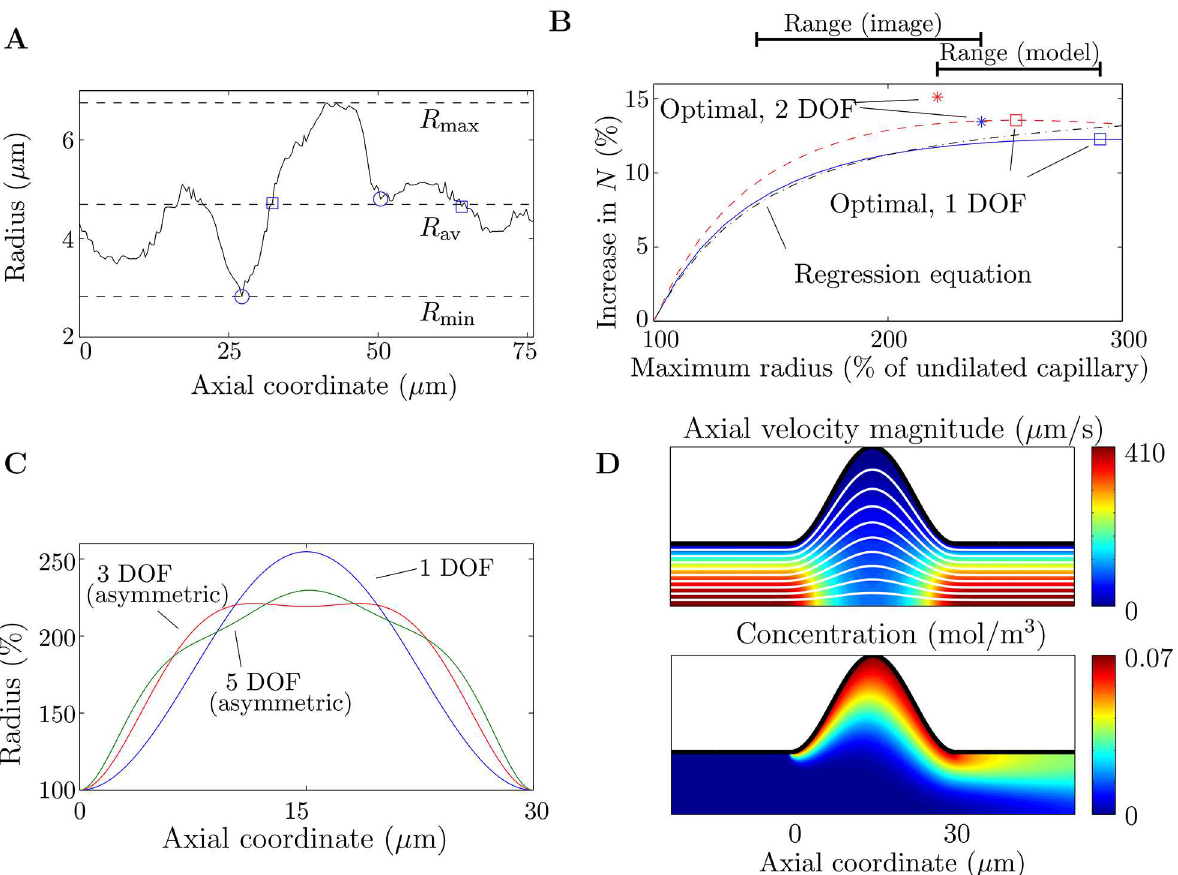
Fig 4. Results from the idealized axisymmetric model of a fetal capillary dilation. (A) Radius of the capillary (of length L = 76 μ m) in Image 1 before it branches, showingthe dilationand the different ways used to define its length λ . Local minima are denoted with circles (this is subjective due to noise in the data). Points where the radius of the dilation equals the averageradius are denoted with squares. The dashed lines show the minimum radius R min = 2.8 μ m, the average radius R av = 4.7 μ m and the maximum radius R max = 6.8 μ m. (B) Increase in oxygen transfer rate for a capillary dilation comparedto a straight capillary. Included in the figure are results for shapes with 1 degree of freedom (DOF), with the undilatedradius being R min ( λ = 23 μ m, Pe eff = 285; blue solid line) and R av ( λ = 31 μ m, Pe eff = 475; red dashedline). Indicated on the figure are the maximum radius and the increase in the oxygen transfer rate N for the optimal shapes in each case with 1 DOF (squares) and 2 DOF (stars). The black dash-dottedline shows the predictionsof the regressionEq (15), for a capillarydilation with 1 DOF, with the undilatedradius defined as R av . (C) Optimal shapes for successively increasing DOF. Where the shapes are asymmetric about the axial midpoint of the dilation, this is labeledon the figure. The shapes correspond to the case where the undilated radius of the capillary is defined as R av , and are plotted as a percentageof the undilated radius. (D) Top: Axial velocity magnitude, with streamlines in white. Bottom: Concentration. Results are shown for the optimal dilation with 1 DOF, in the case where the undilatedradius is taken to be R av . It has been assumed that the centrelineflow velocity in a straight capillary is equal to 300 μ